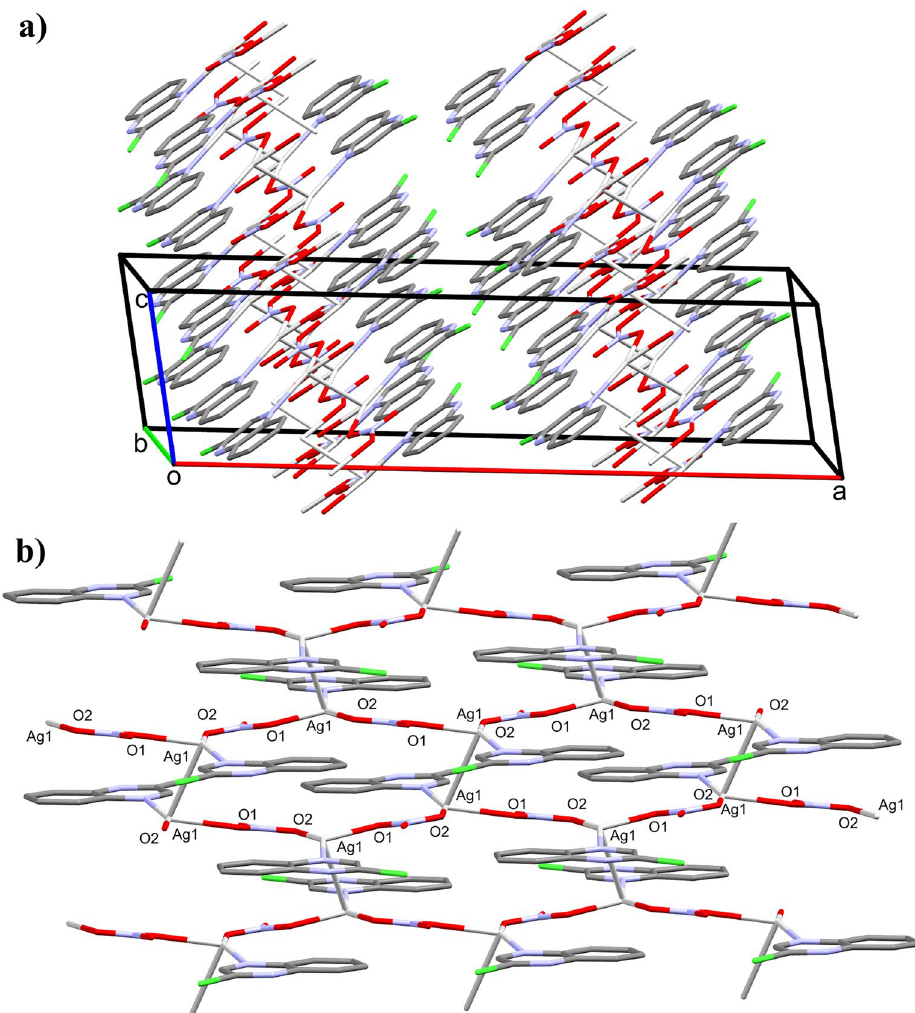
Figure 4. Projections of the crystal packing in the unit cell ( a ), and the two-dimensional infinite coordination polymer of complex 1 ( b ). All hydrogen atoms are omitted from this figure for better